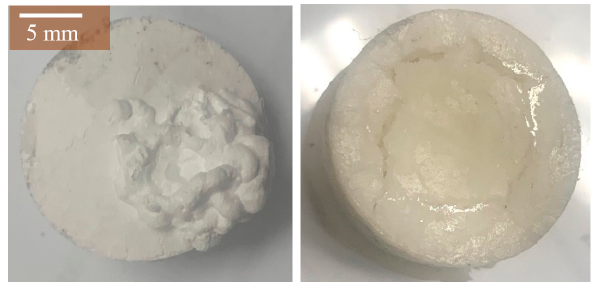
Figure 4. MSH pellet on the left and SrBr 2 · 6H 2 O (SBH) pellets on the right after first dehydration test at 85 °C, 5% RH. Both pellets were manufactured under a 5.2 kN ⋅ mm − 2 compression pressure.